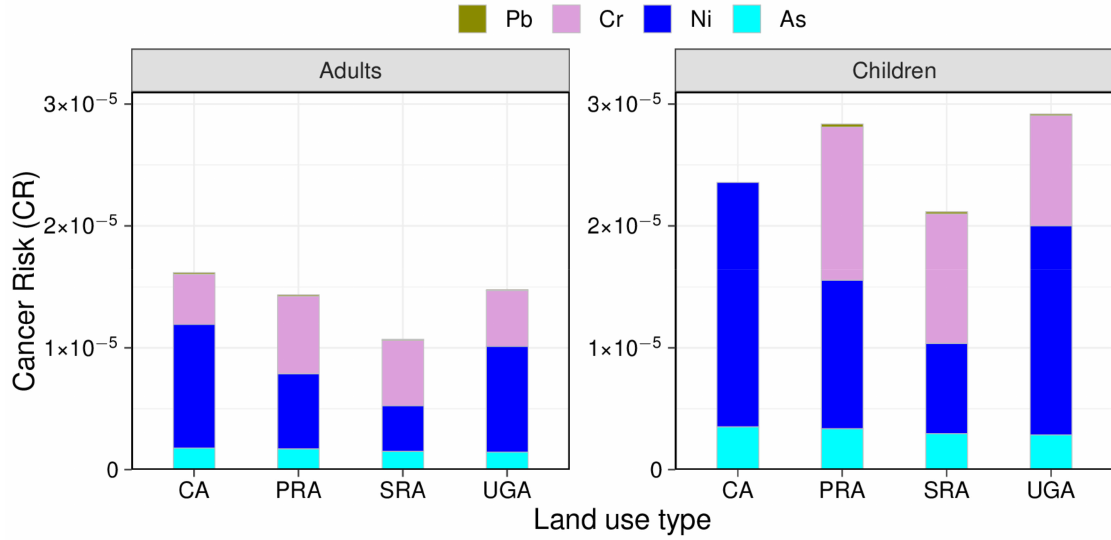
Figure 6. Carcinogenic risk of elements (Pb, Cr, Ni and As) in roadside dust in Dhaka city. CA = commercial area, PRA = planned residential area, SRA = spontaneous residential area, UGA = urban green